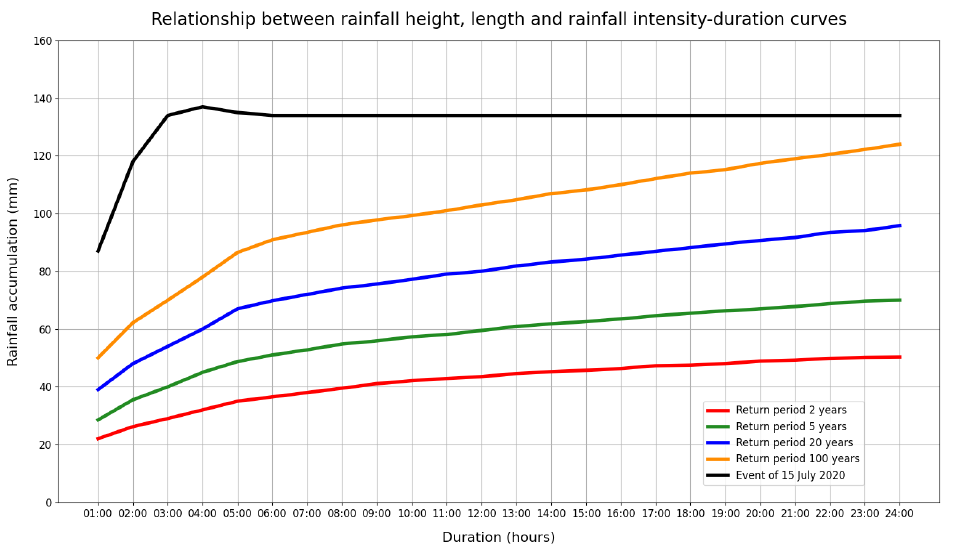
Figure 17. The figure shows the return periods, calculated on the basis of the available data of the CFD-Idro Sicilia. In particular, the curves represent, respectively, events with a return period of two years (red), five years (green), twenty years (blue), and one hundred years (orange). The black curve represents the event recorded on 15 July